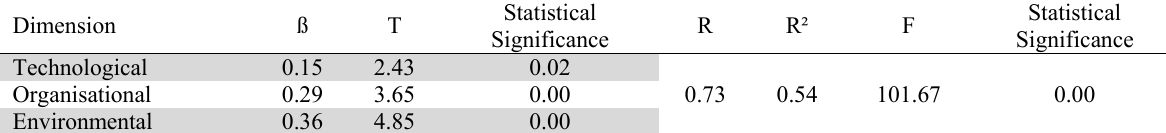
Results of Applying the Multiple Regression Equation to Study the Impact of Adopting E-Collaboration Tools on Knowledge Storage Dimension ß T